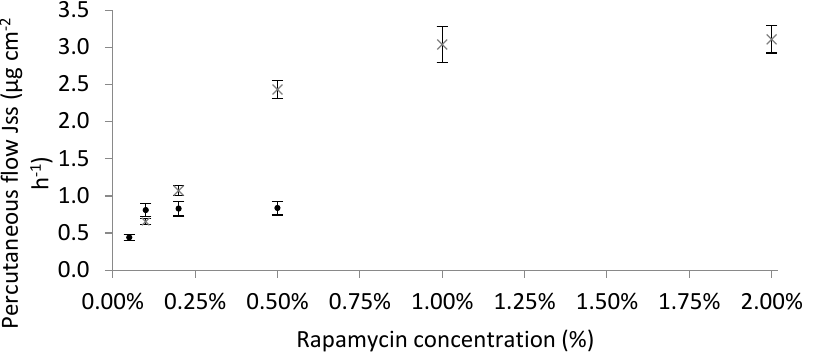
Figure 2. Impact of steady-state flux as a function of rapamycin concentration through Strat-M ® membrane. × corresponds to F3 (0.1% rapamycin solubilized in Transcutol ® P and mixed in Excipial ® hydrocream) and ● corresponds to F5 (0.1% rapamycin hydro-alcoholic gel). The percutaneous flux increases with the concentration of active ingredient until reaching a state of saturation corresponding to the maximum thermodynamic activity. Each point corresponds to the mean of 6 assays ± SD.